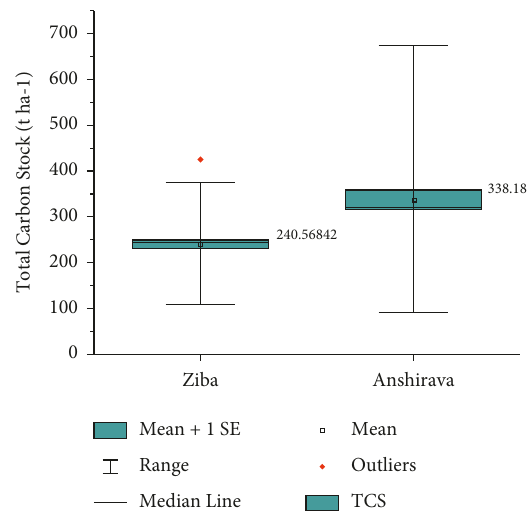
Figure 6: Total carbon stock of the studied forests.